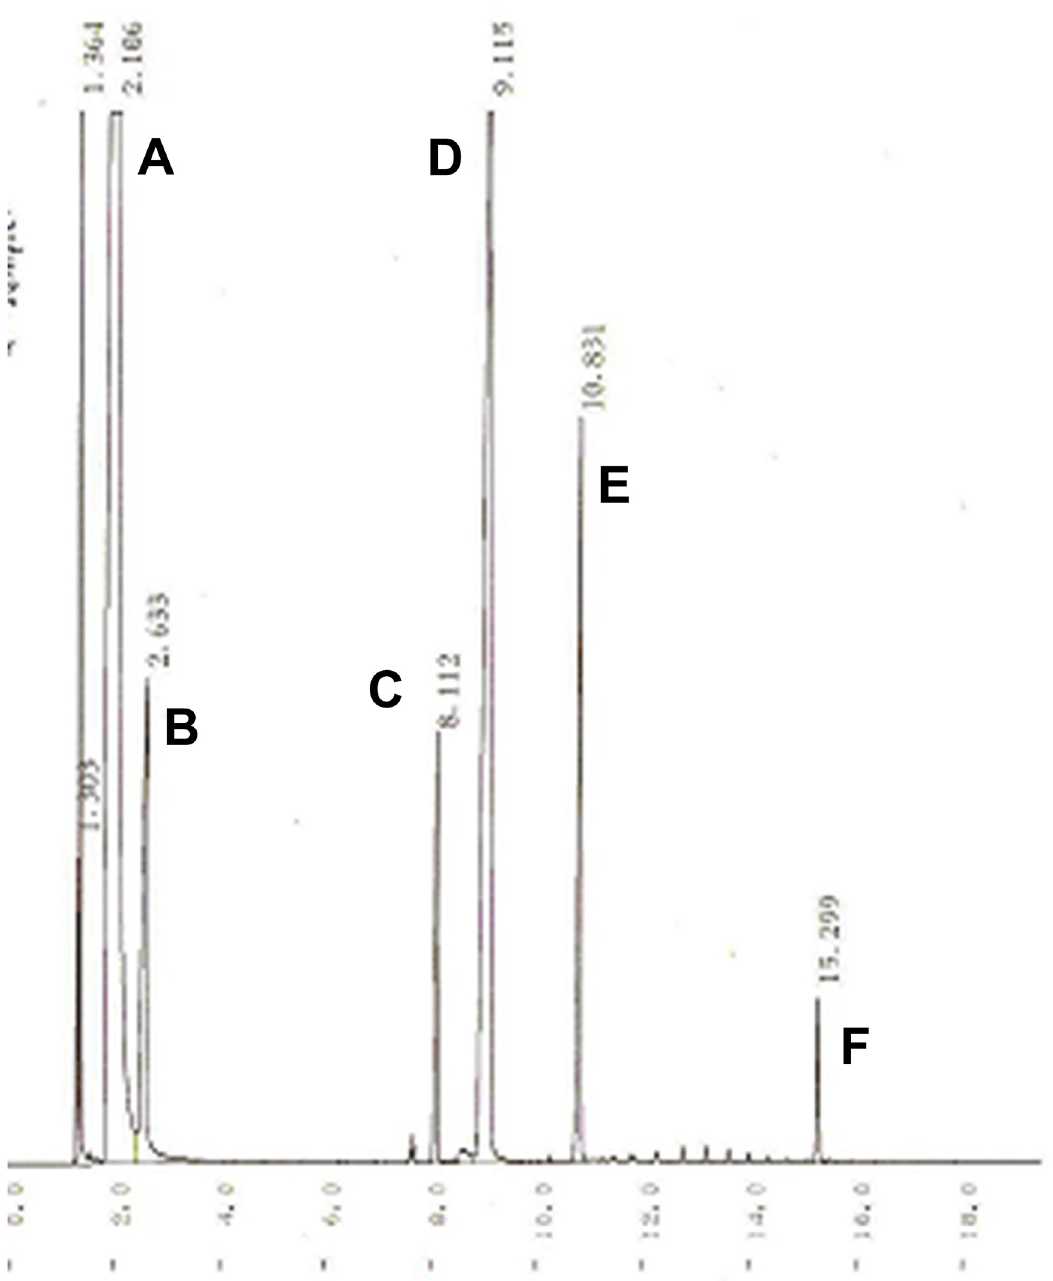
Fig 6. Gas chromatography of palm-based kojic monooleate ester. Peaks A = N , N -dimethylformamide, B = N , O -bis-trimethylsilyl acetamide, C = Kojic acid, D = internal standard (1,2,3-tributyrylglycerol), E = oleic acid, F = palm-based kojic monooleate ester (KMO).